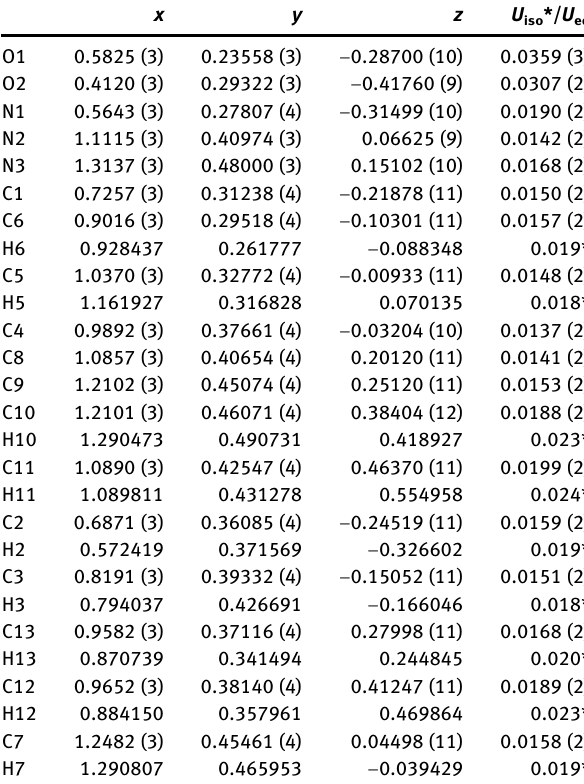
Table  : Fractional atomic coordinates and isotropic or equivalent isotropic displacement parameters (Å 